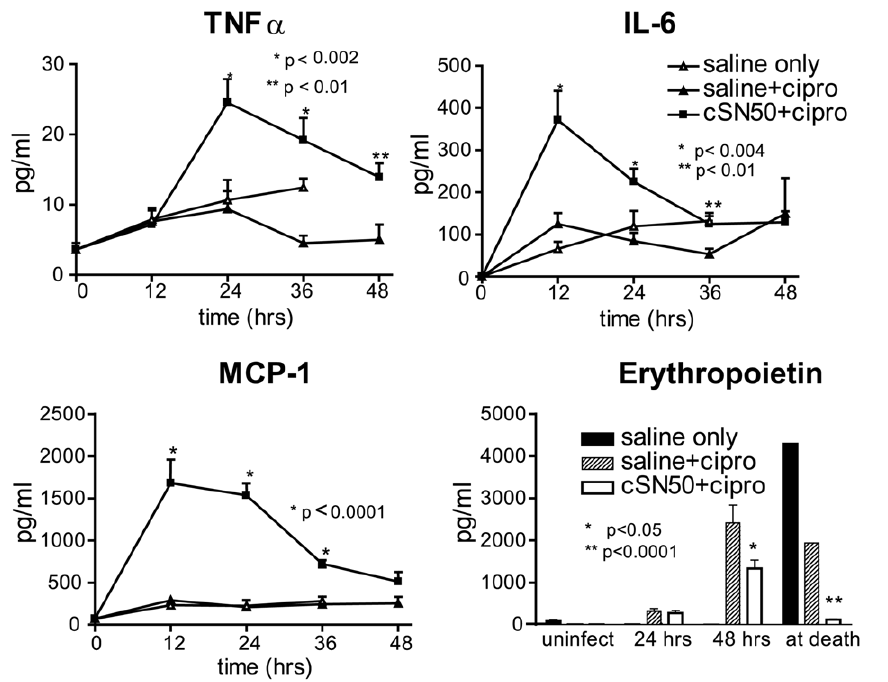
Figure 2. cSN50 restored depressed cytokine/chemokine responses to B.anthracis infection and attenuated a rise in erythropoietin, a hypoxia biomarker. Blood serum levels of TNF a , IL-6, and MCP-1 were measured in female A/J mice infected with 10 7 B. anthracis spores IN and treated with cSN50 and daily ciprofloxacin (solid squares) or saline and ciprofloxacin (solid triangles) or saline without ciprofloxacin (open triangles) as in Fig. 1. Blood serum levels of Erythropoietin were measured in the same mice: cSN50 and ciprofloxacin (white), saline and ciprofloxacin (diagonal lines) or saline without ciprofloxacin (black). Error bars indicate the + S.E. of the mean value in mice represented by each data point. The p values represent the significance of the differences between the two ciprofloxacin-treated